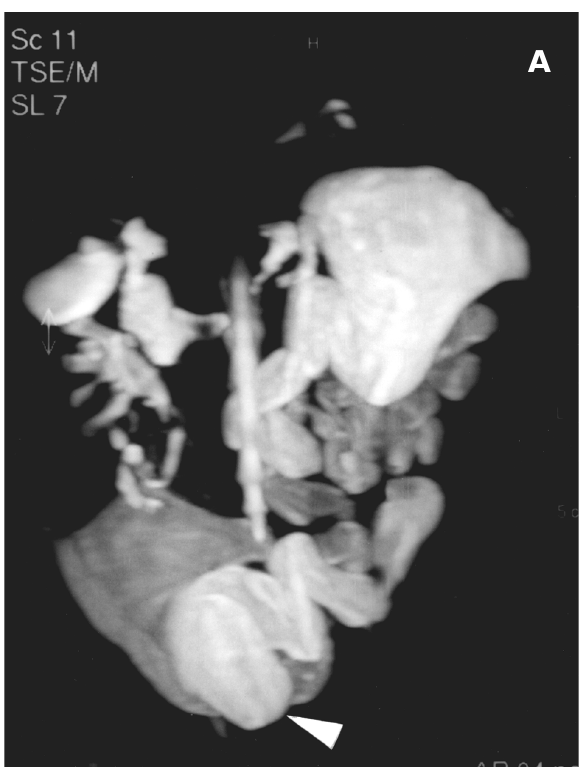
Figure 1 A – Weighted image in T2, in frontal plane, showing pyeloureteral duplicity and ureterocele (arrow).